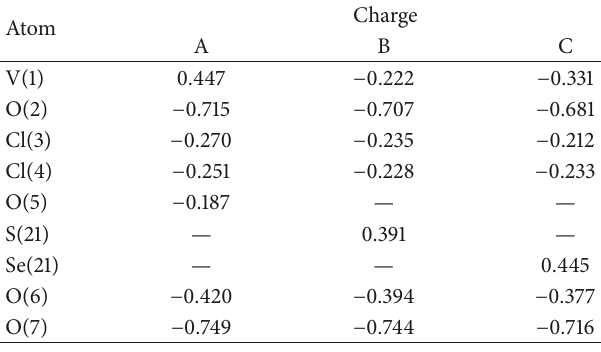
Table 3: NPA charge distribution of respective atoms in the